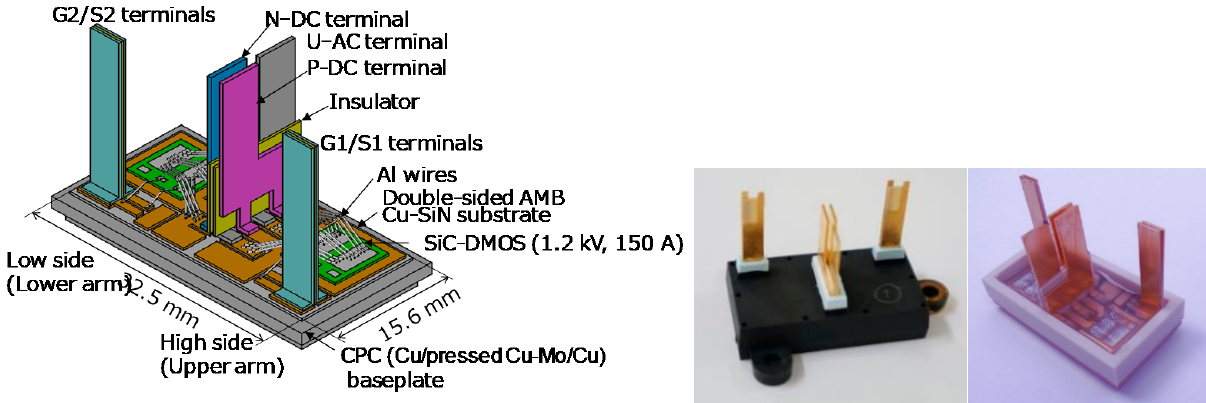
Figure 2. Developed ultra-small SiC half-bridge inverter module. 1200 V-150 A rated and the module was confirmed to work under 250 degrees temperature conditions.